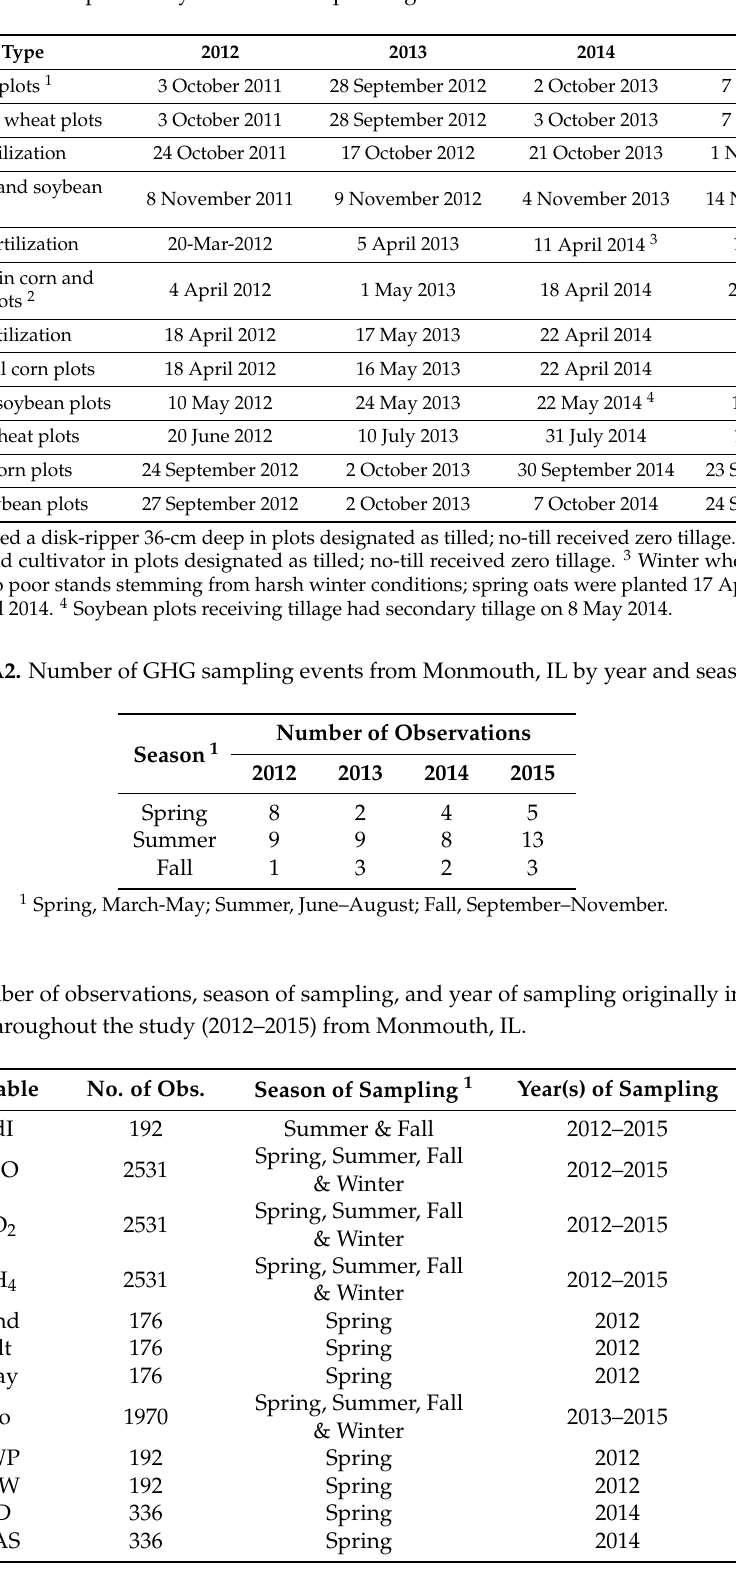
Table A1. Field event dates from Monmouth, IL throughout the duration of the study. Wheat plot operations began in the previous year due to fall planting.